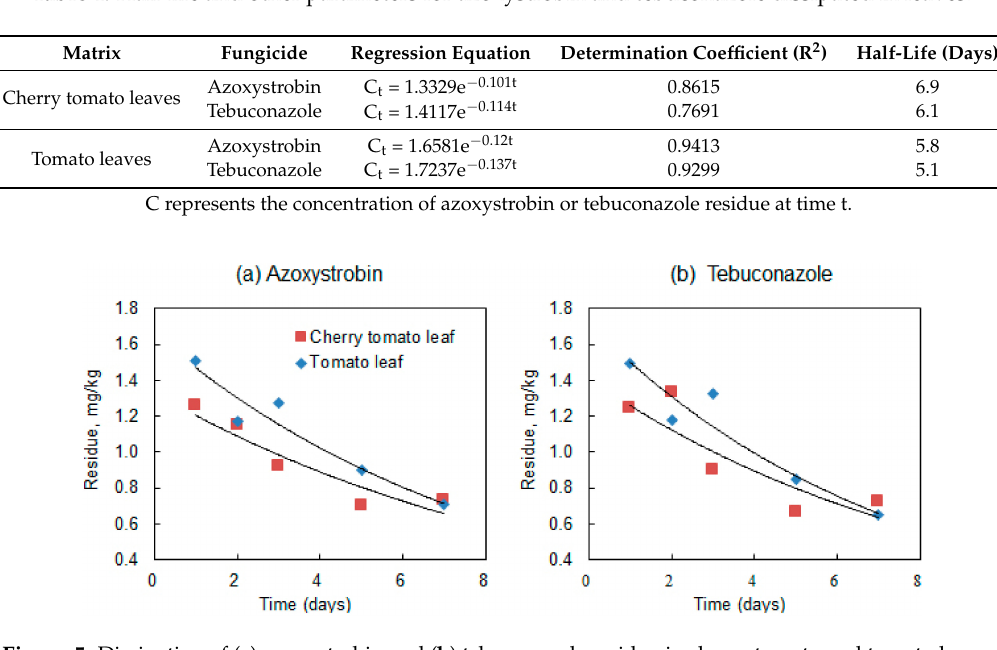
Figure 5. Dissipation of ( a ) azoxystrobin and ( b ) tebuconazole residue in cherry tomato and tomato